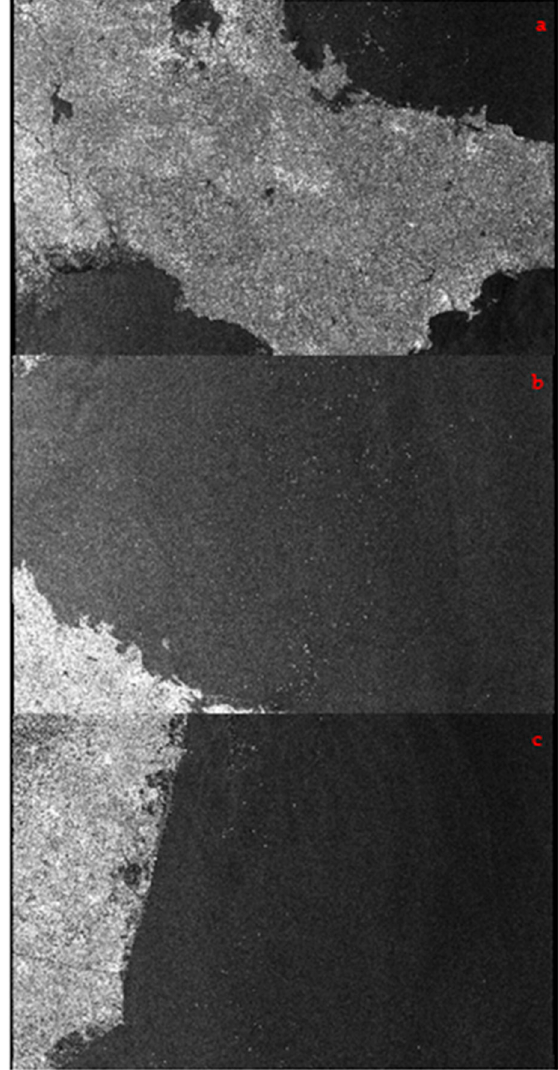
Figure 7. SAR image of the South Yellow Sea area on 12 July 2021. ( a ) Qingdao, ( b ) Rizhao and Liangungang, and ( c ) Yancheng and Nantong.